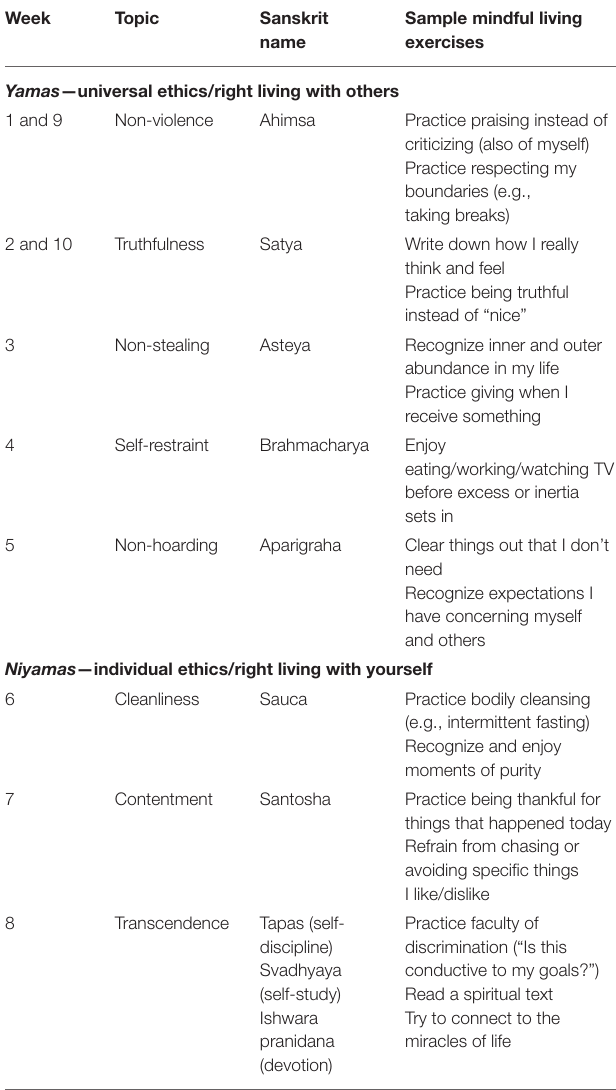
TABLE 3 | Topics of the ethical education component with corresponding week(s) they were taught in the study, sanskrit names, and sample mindful living exercises. Week Topic Sanskrit Sample mindful living name